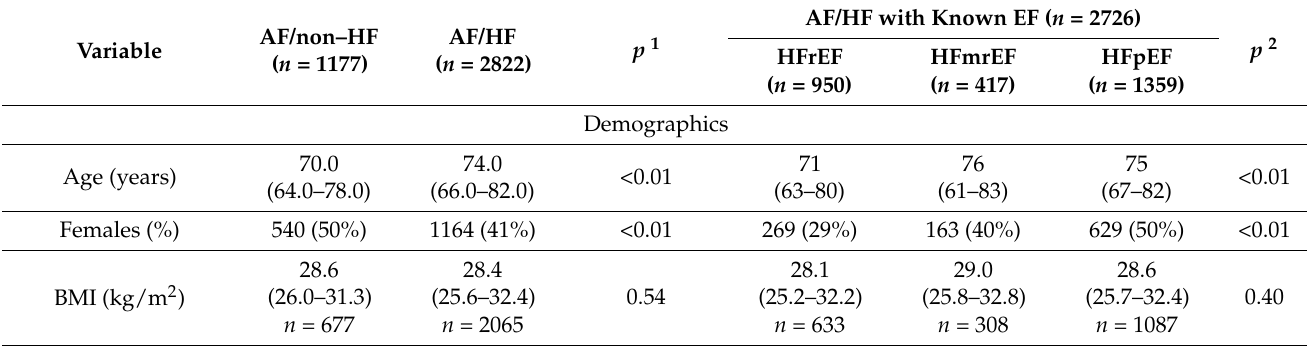
Table 1. Baseline characteristics of hospitalized atrial fibrillation patients depending on presence or absence of heart failure and its